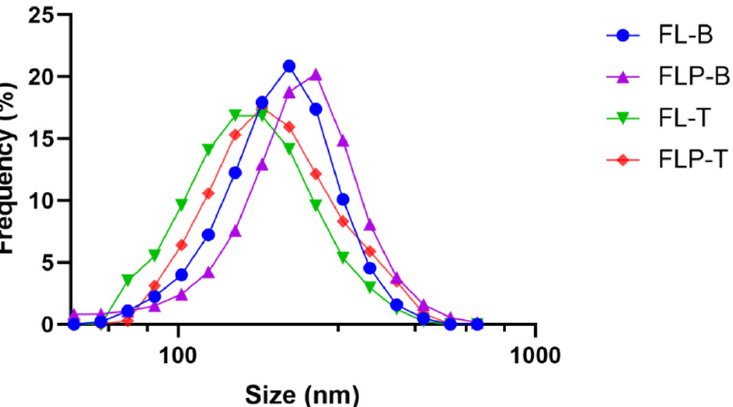
Figure 1. Particle size distribution of liposomal formulation containing brimonidine with (FLP-B) and without (FL-B) HPMC 0.2% and travoprost with (FLP-T) and without (FL-T) HPMC 0.2% represented in a semi-logarithmic scale.